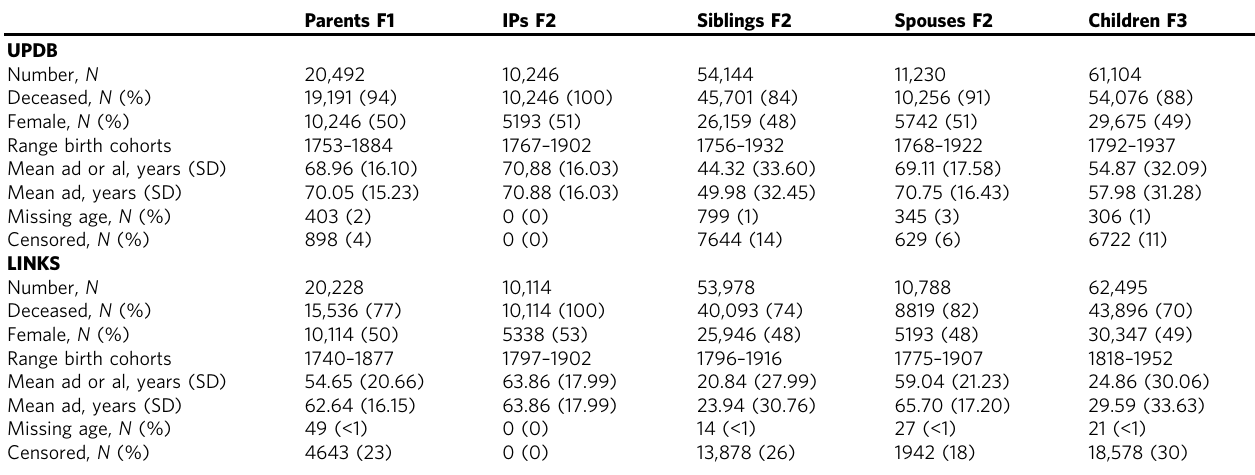
Table 1 Overview of UPDB and LINKS index persons and their fi rst-degree relatives and